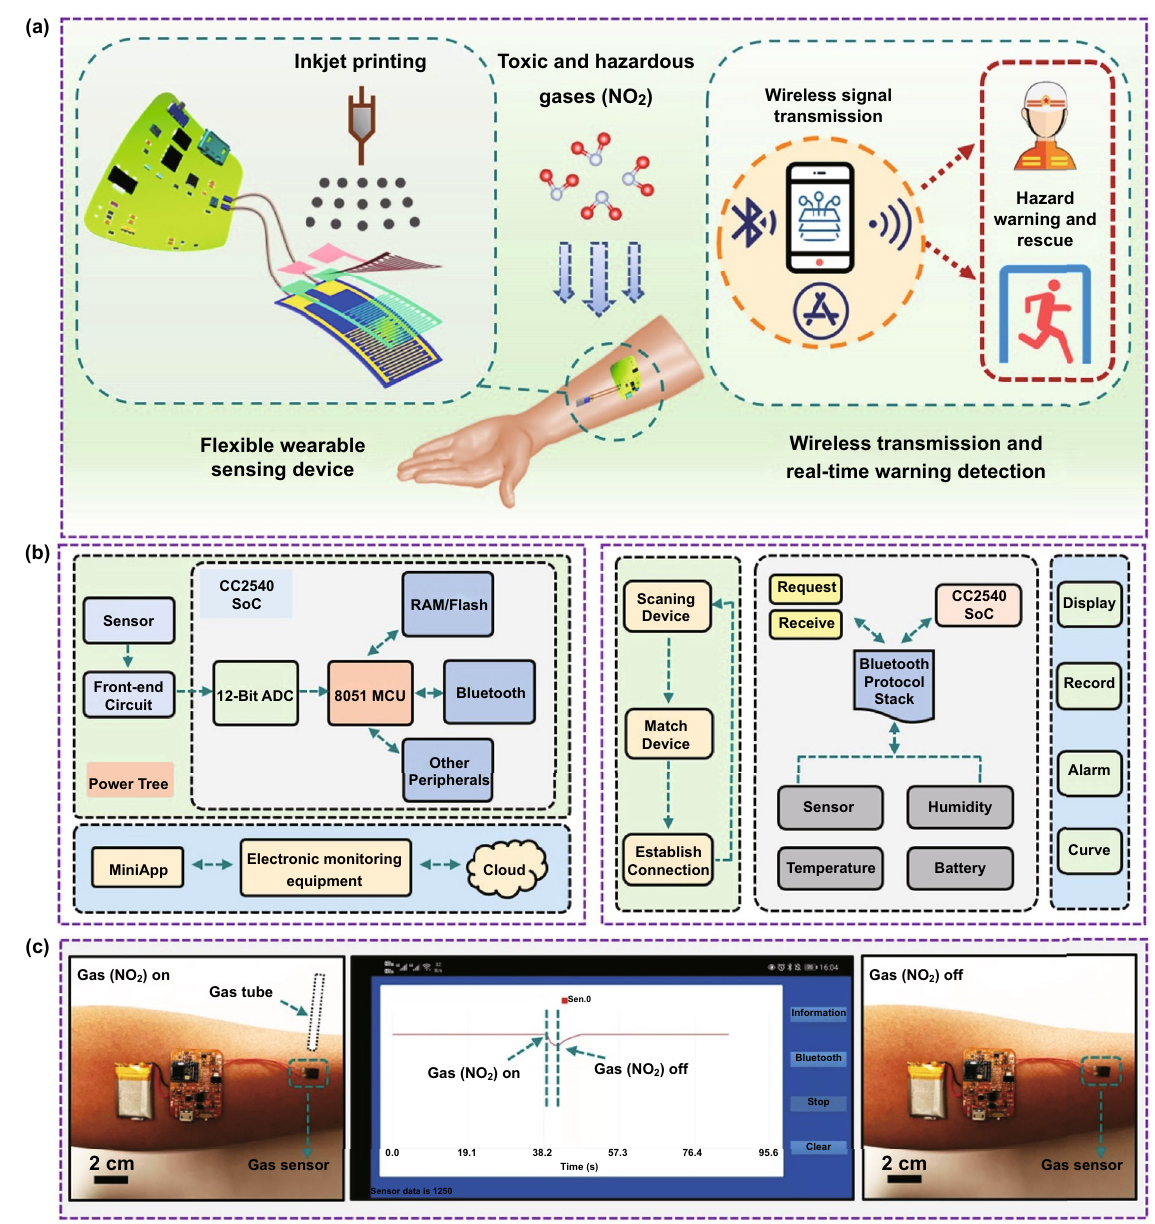
Fig. 6 Application process of the wireless wearable sensor system. a Schematic diagram of structure and application concept of wireless wear- able devices. b Circuit hardware and software logic block diagram. c Photographs of the change in response to NO 2 gas by smartphone applica- tion during the actual